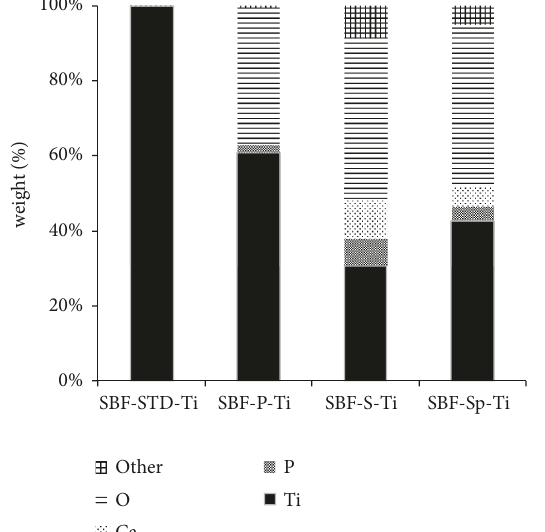
Figure 4: AES spectra of the outermost surface of each Ti plate.